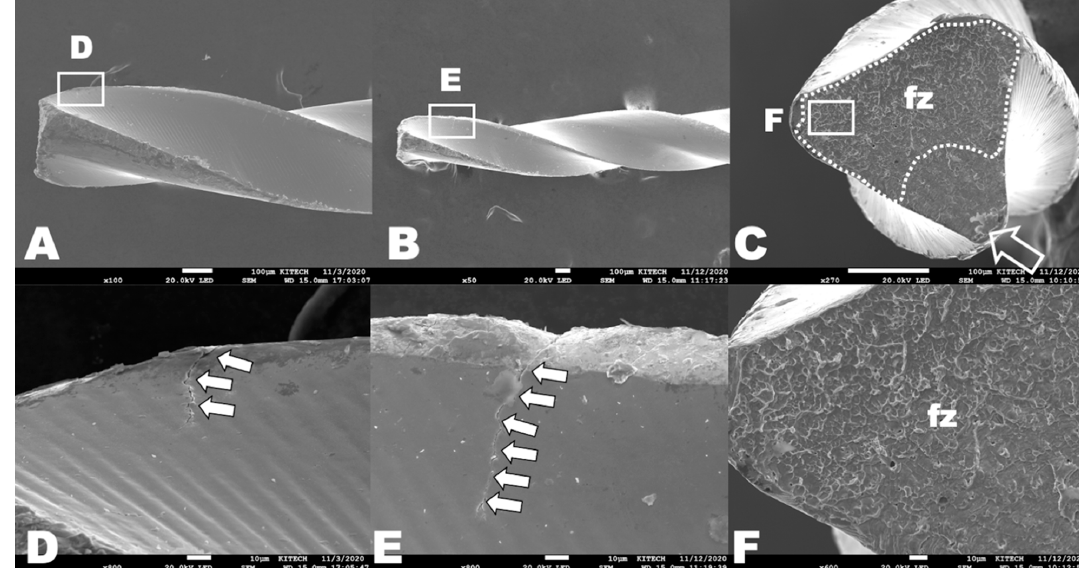
Figure 2. Scanning electron micrographs of the fracture fragments after cyclic fatigue tests. Longi ‐ tudinal aspects from the samples of group ‐ N ( A ) and group ‐ U ( B ). Cross ‐ sectional aspect from one sample of group ‐ S ( C , F ). ( A , B ) Fractured instruments from the cyclic fatigue tests did not show macroscopic changes. ( C ) White open arrow indicates crack initiation area. Areas outlined with dot line indicate fatigue fracture zone (fz) with numerous ductile dimples ( F ). ( D , E ) White arrows indi ‐ cate microcracks near the fracture area. No specific differences according to the groups.